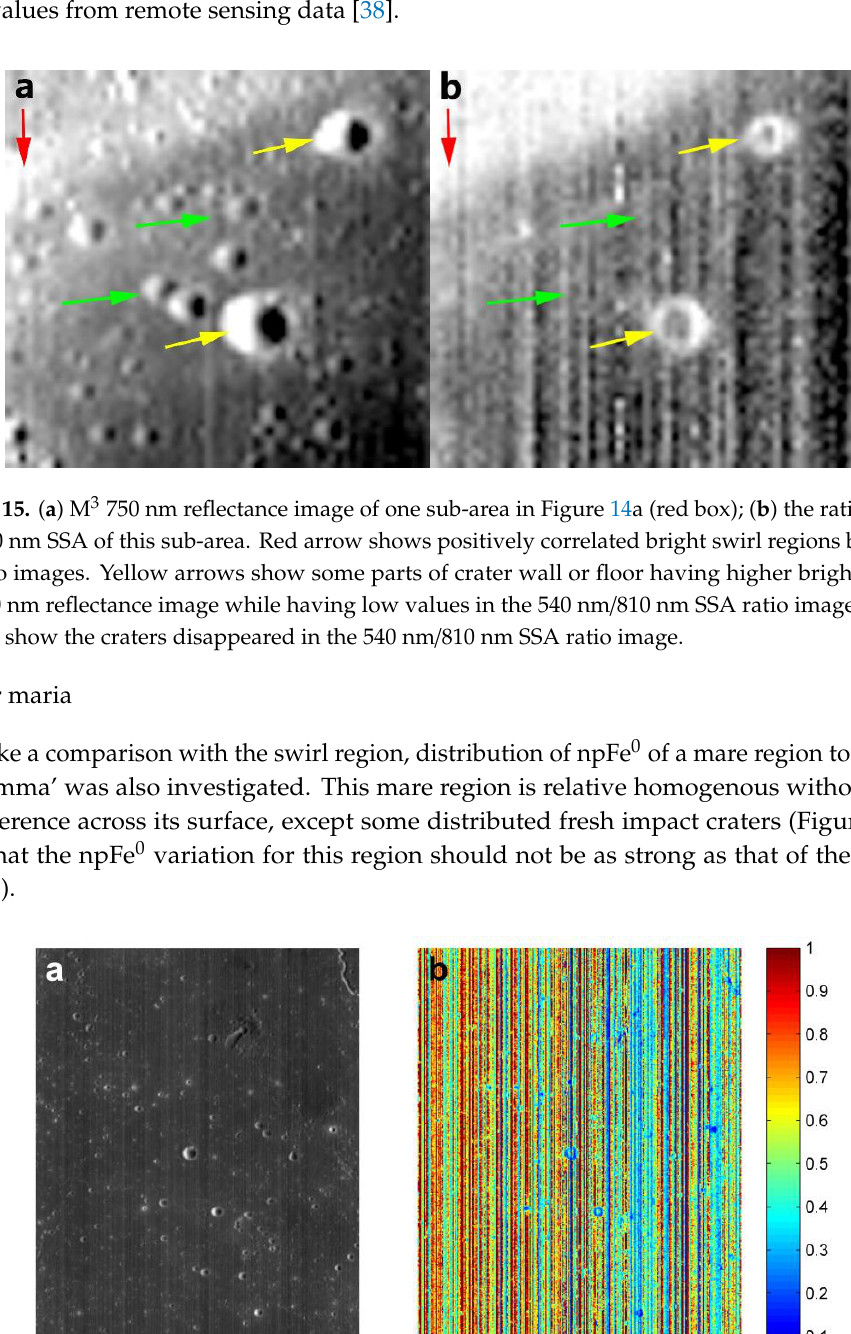
Figure 14. ( a ) M 3 750 nm reflectance image for lunar swirl ‘Reiner Gamma’ ; ( b ) npFe 0 abundance distribution of ‘Reiner Gamma’.